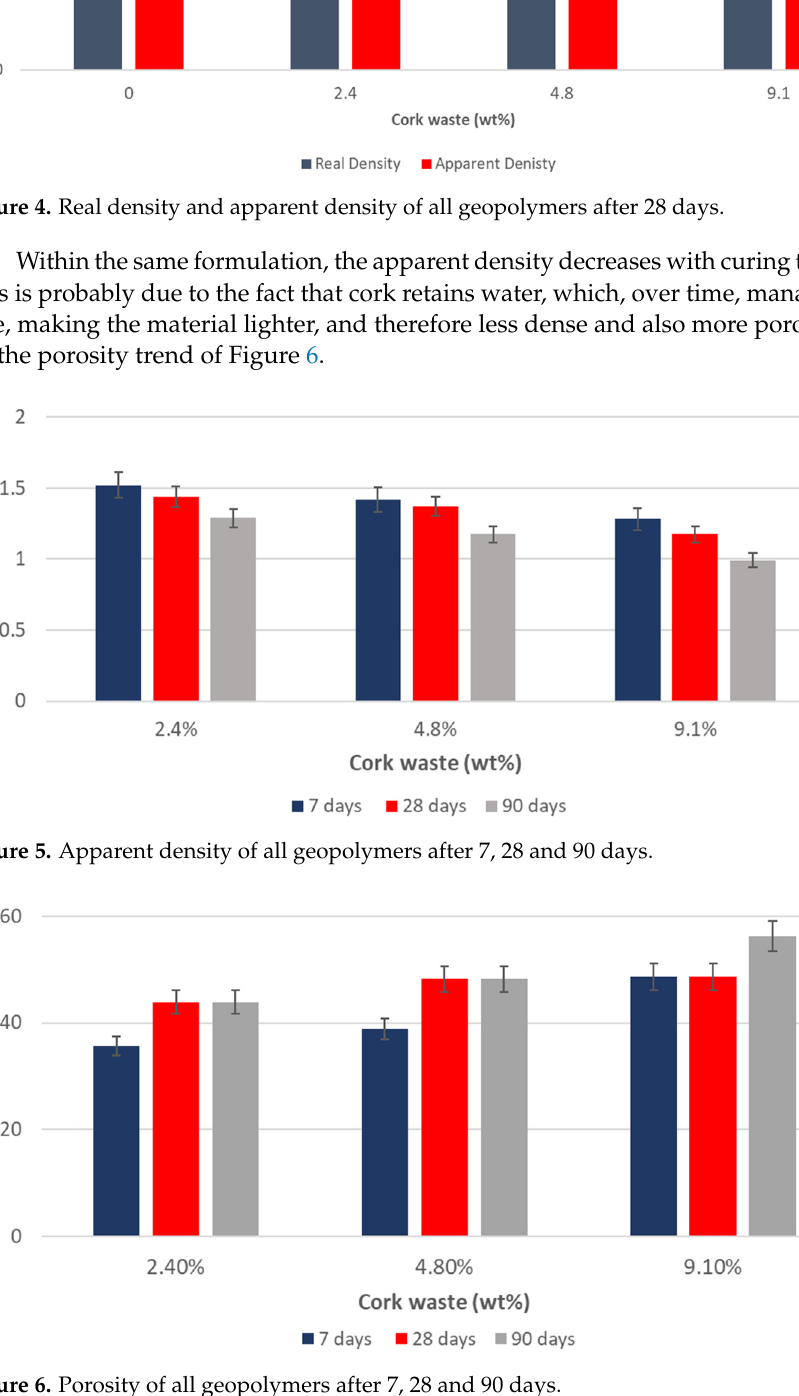
Figure 6. Porosity of all geopolymers after 7, 28 and 90 days.